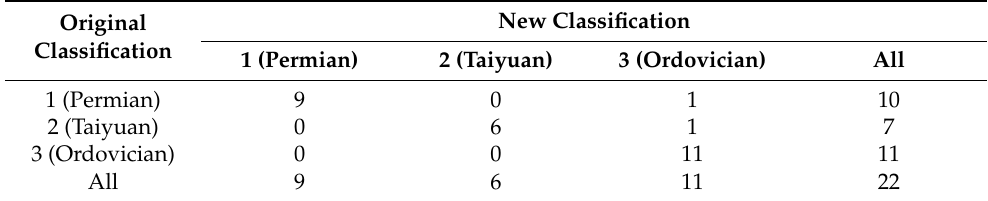
Table 13. Retrospective discrimination results of modified Bayes multi-class LDA